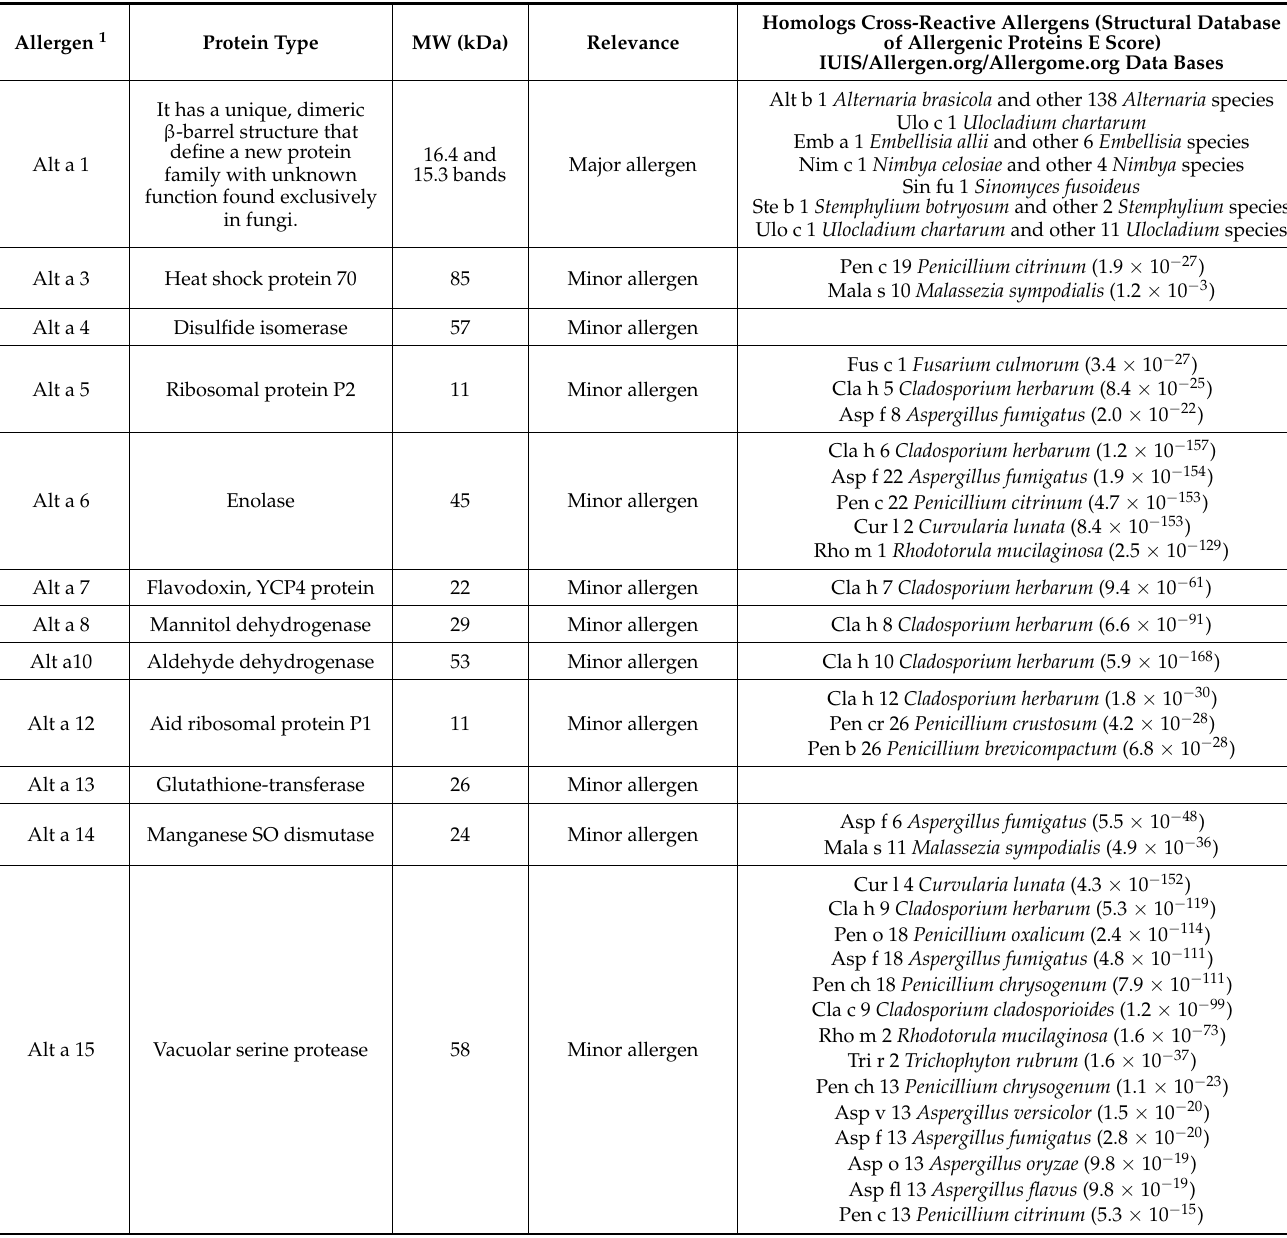
Table 1. Alternaria alternata allergens and their cross-reactivity with homologous proteins from other fungal